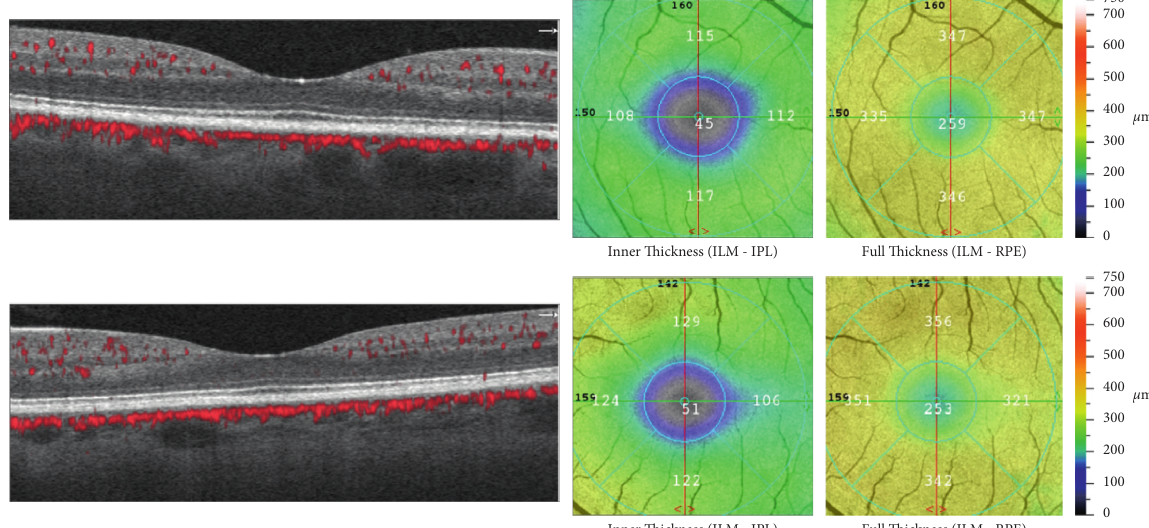
Figure 2: The thickness of the retina obtained by OCTA from a patient suffering from type 2 diabetes (abovementioned) and a subject who is healthy (below).